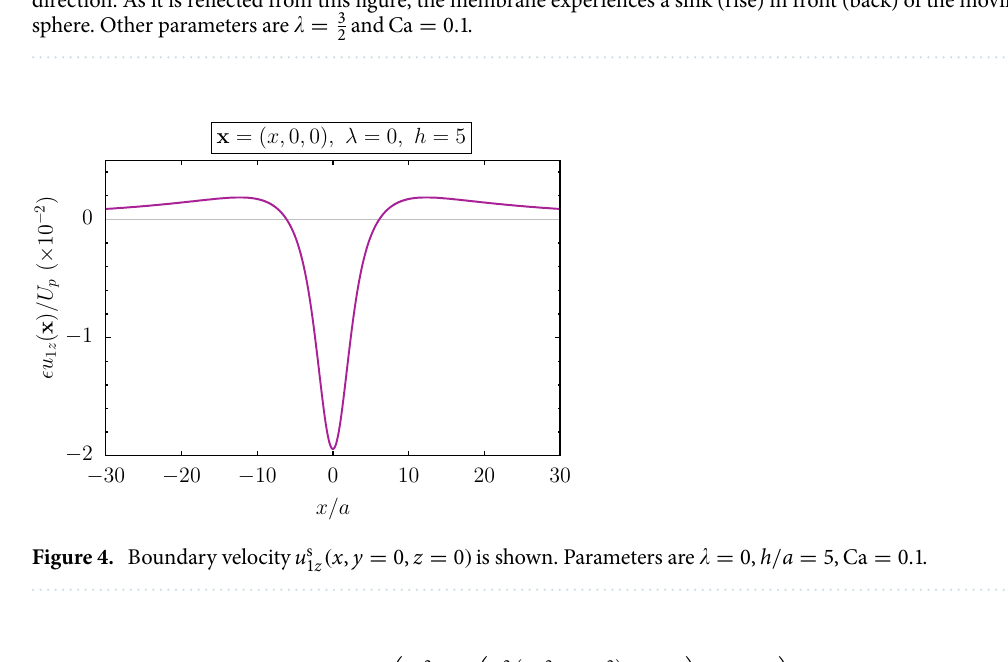
10 ) and moving in x − +ˆ